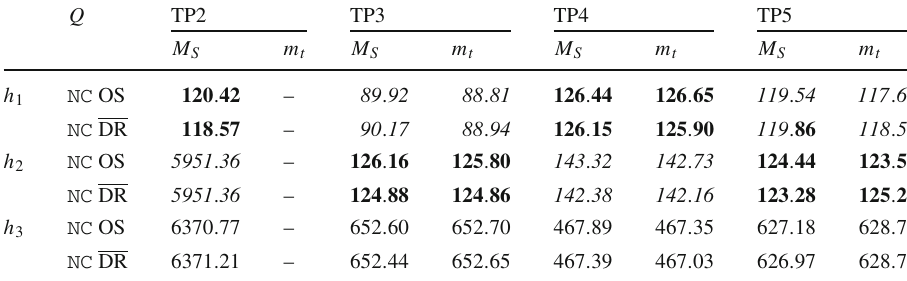
Table 10 Mass predictions